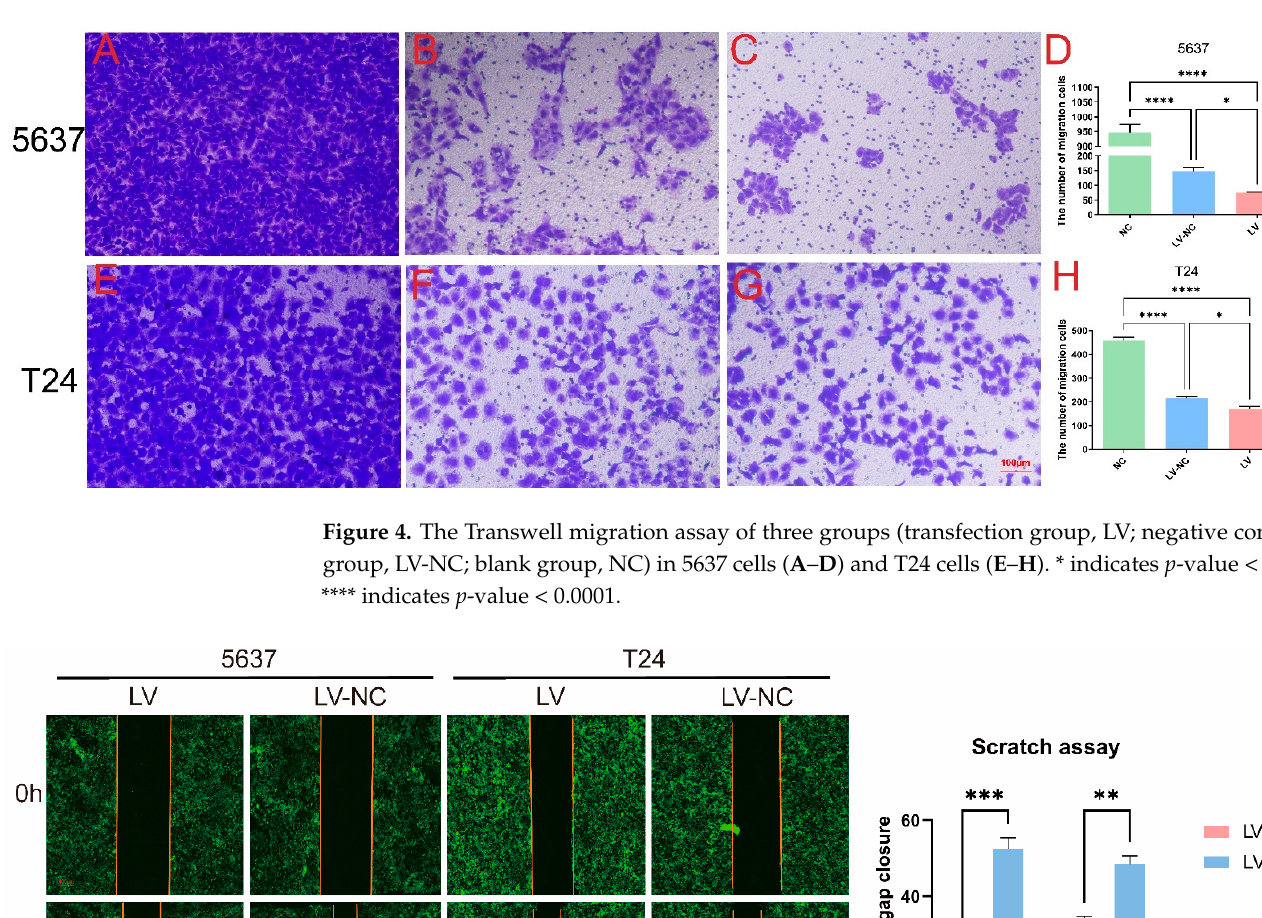
Figure 3. The Transwell invasion assay of three groups (transfection group, LV; negative control group, LV-NC; blank group, NC) in 5637 cells ( A – D ) and T24 cells ( E – H ). **** indicates p -value < 0.0001.